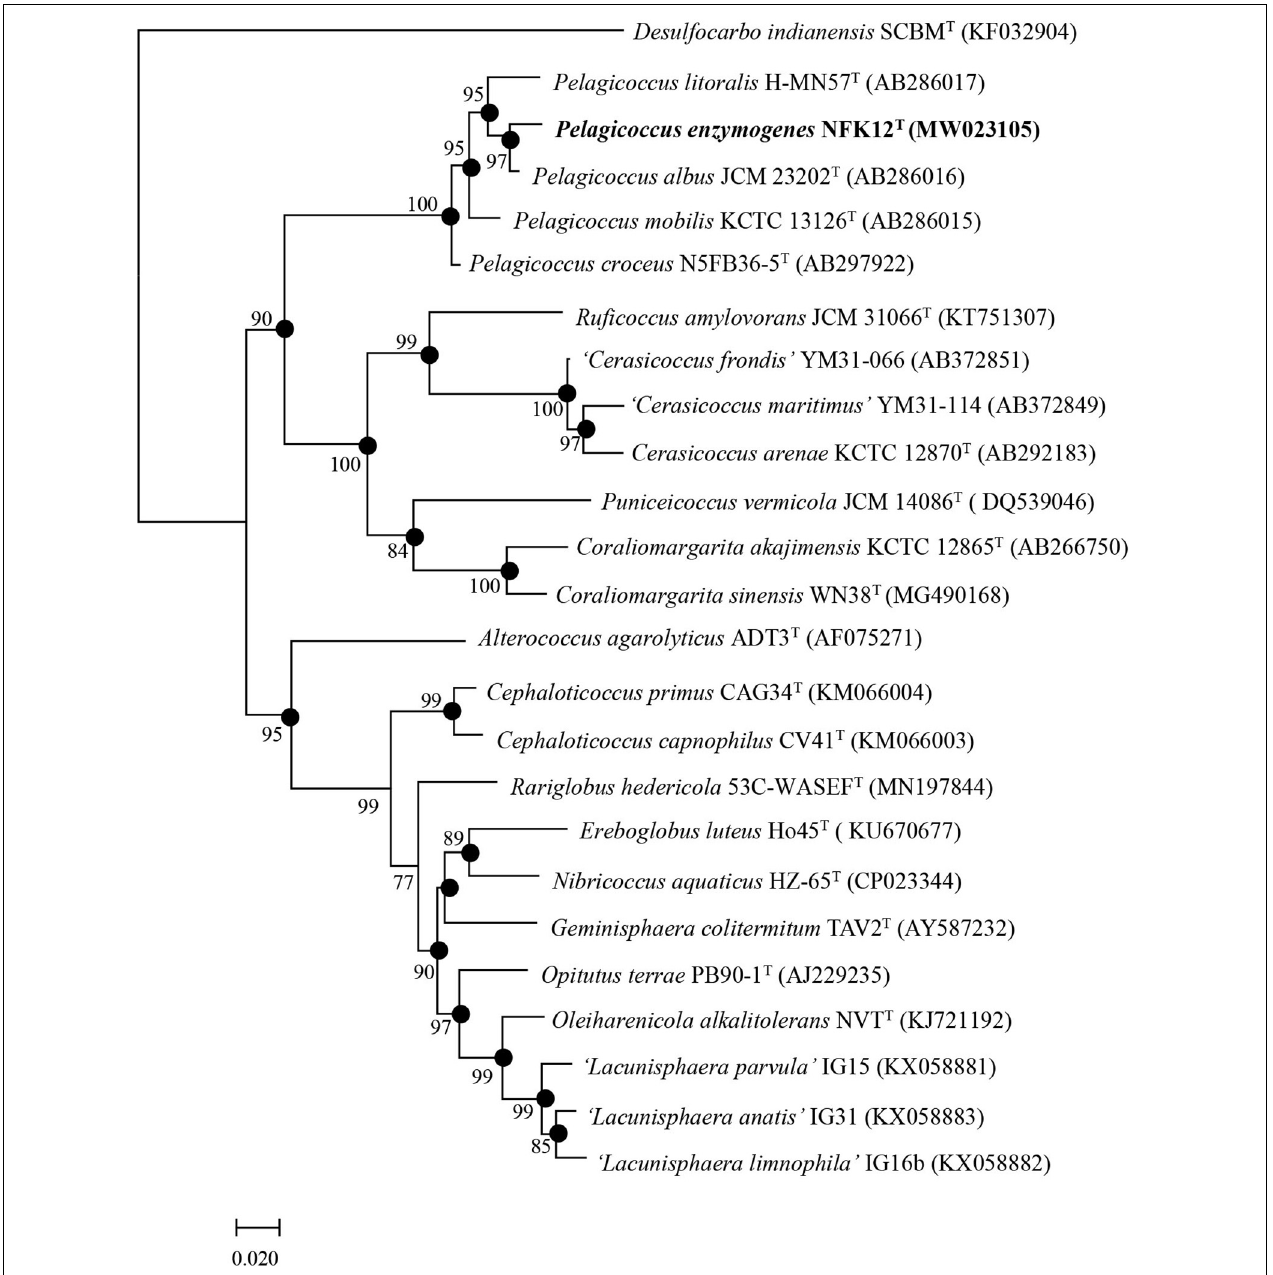
FIGURE 1 | Phylogenetic trees based on the complete 16S rRNA gene sequences from bacterial taxa showing the taxonomic position of strain NFK12 T . Filled circles indicate nodes overlapping on trees reconstructed using FastTree and IQ-TREE algorithms. Numbers on nodes represent bootstrap values (FastTree/IQ-TREE) based on 1,000 replications, and bootstrap values ( > 70%) are shown at branch nodes. Desulfocarbo indianensis SCBM T (KF032904) was used as an outgroup. Bar, 0.02 substitutions per nucleotide